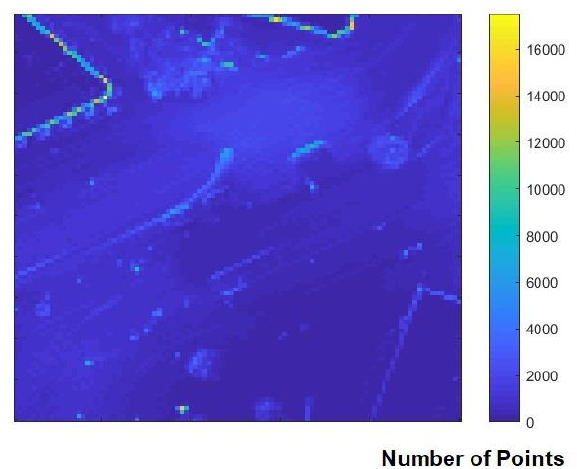
Figure 7. Number of points present within the 50x50cm tiles